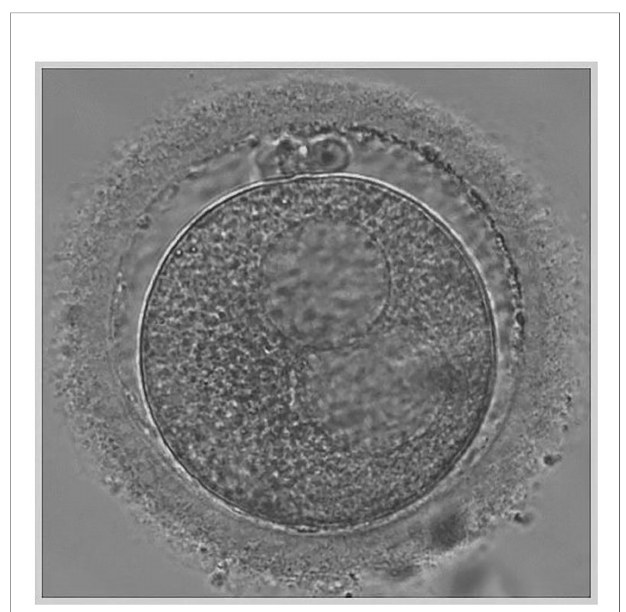
FIGURE 1 | Metaphase II oocyte displaying the SER